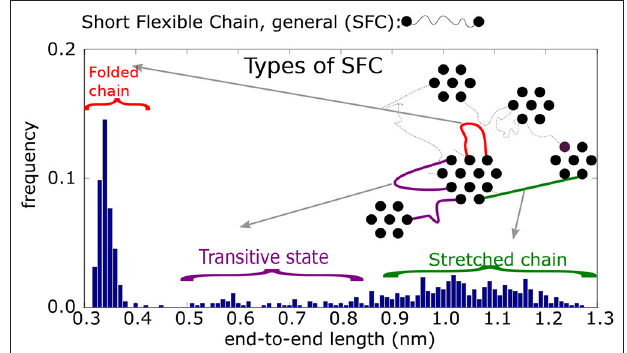
FIGURE 5 | Histogram of end-to-end distances r e of Short Flexible Chains. A SFC is the part of a chain between two physical crosslinks: schematic picture of four types of SFC and their end-to-end